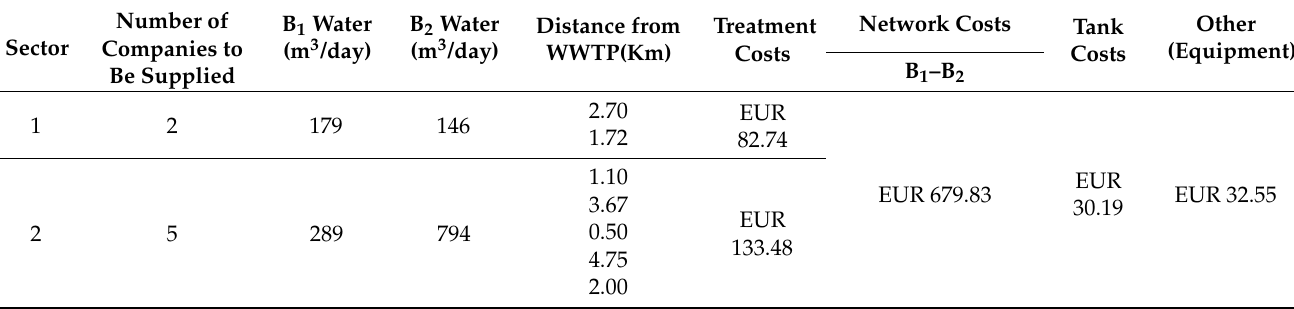
Table 3. Technical and economic characteristics of the industrial areas to be supplied (sectors 1 and 2).